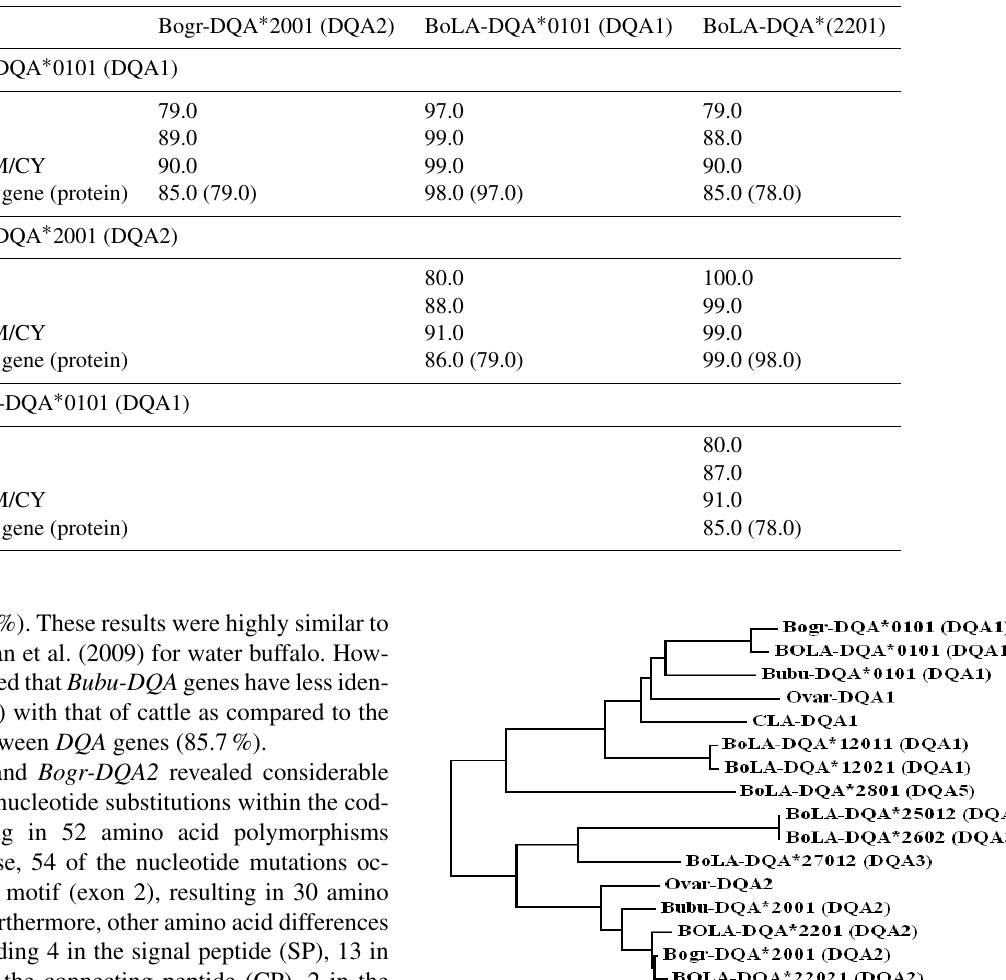
Table 1. Nucleotide similarity comparisons from the α 1, α 2, and CP/TM/CY regions between Bogr - DQA1/DQA2 and BoLA-DQA1/DQA2 genes (the amino acid similarity is shown in parentheses).